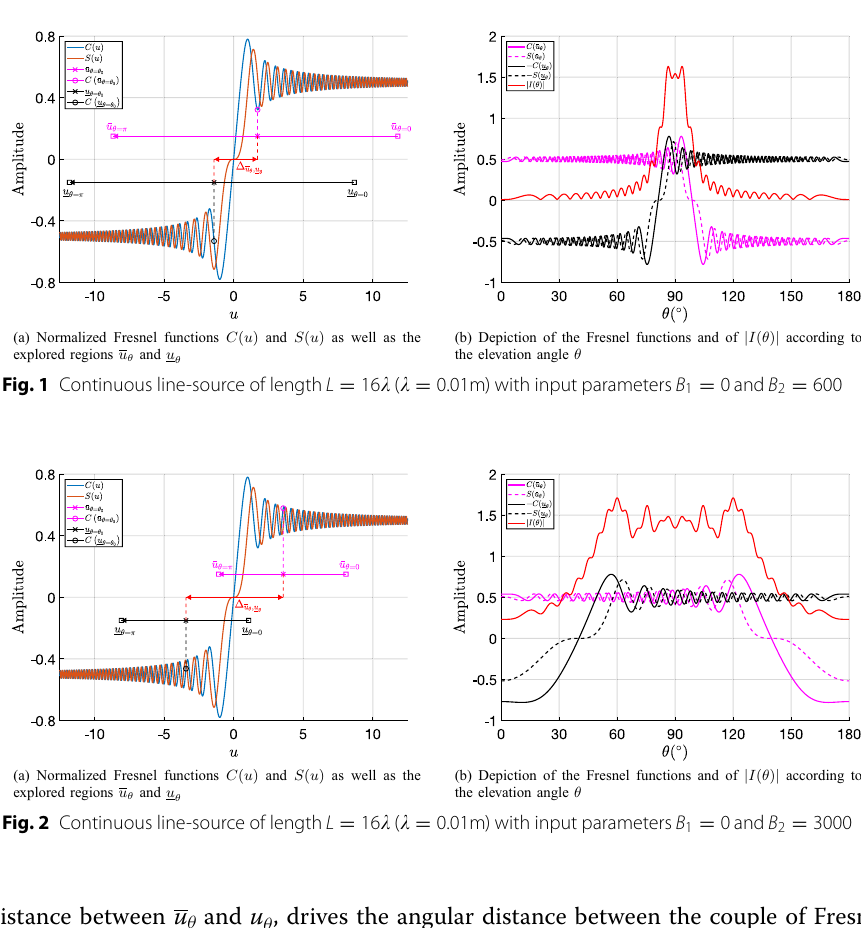
Fig. 2 Continuous line-source of length L